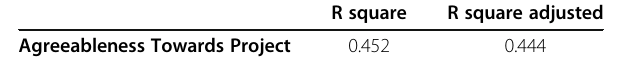
R square R square